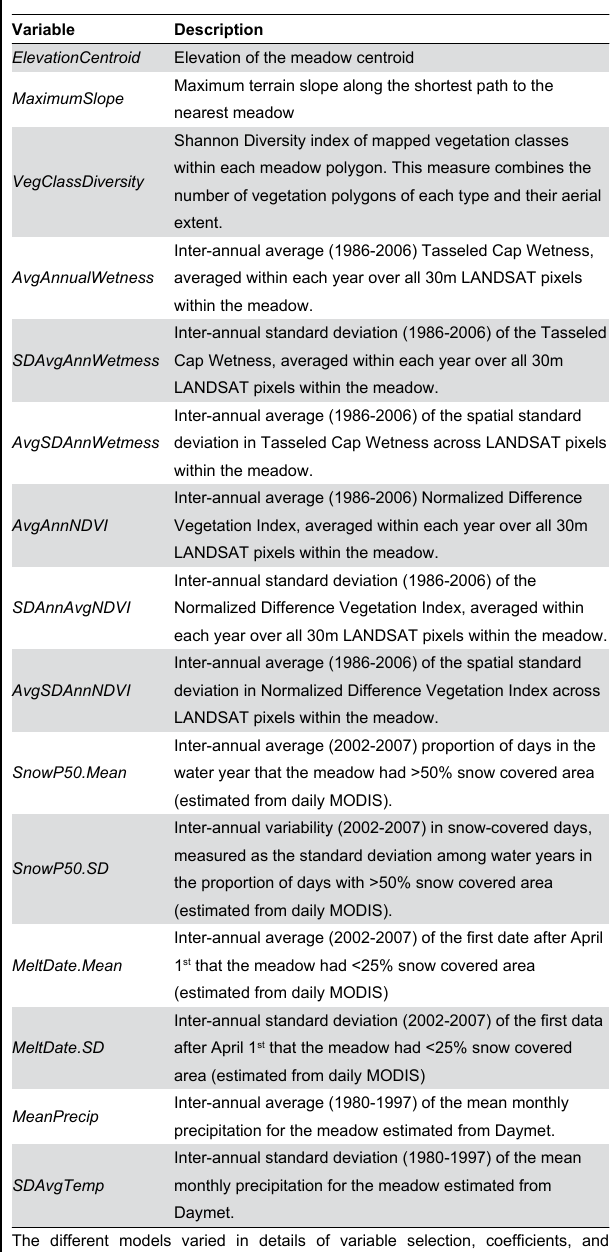
Table 1. Explanatory variables used in the General Linear Models and General Additive Models chosen from the full set because they were not highly correlated (r <